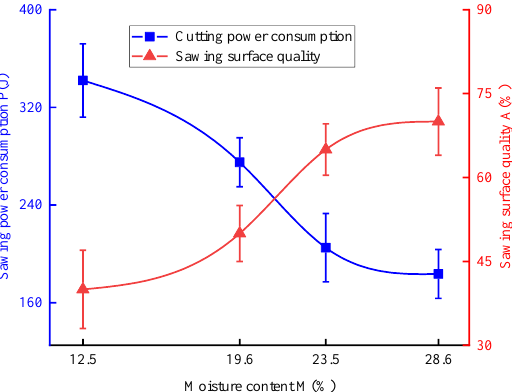
ing speed 40 m/s; feeding speed 0.35 m/s; number of teeth 80; moisture content 25.0~29.9% ).